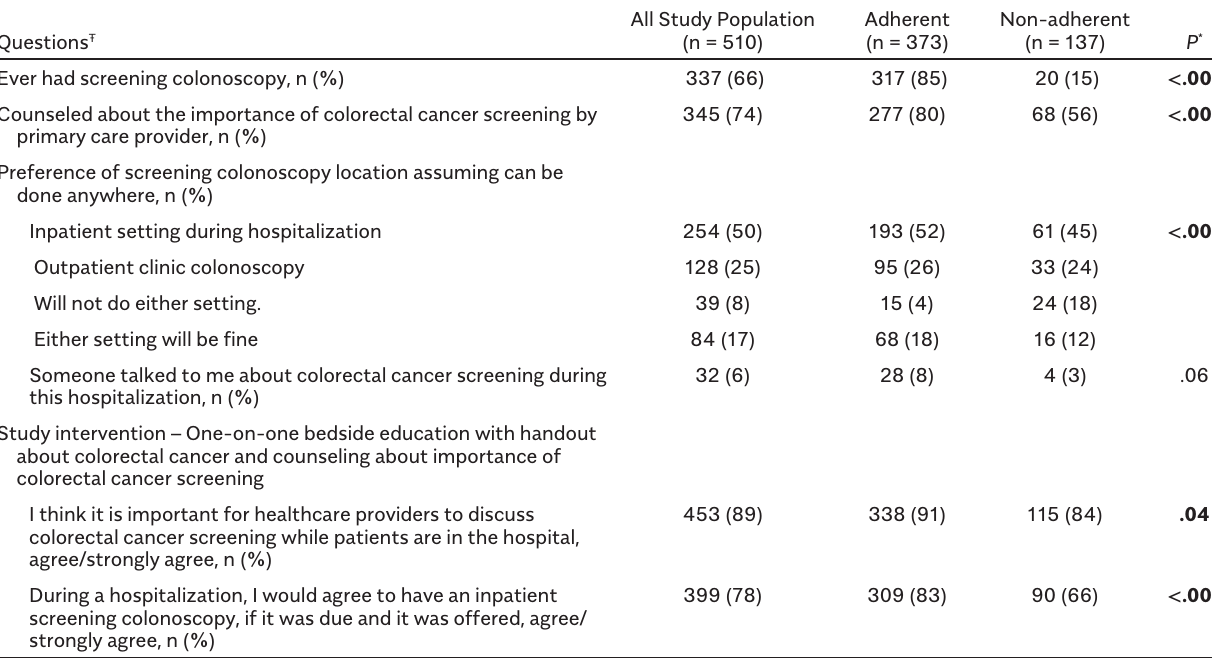
Table 3. Care Received During Hospital Admission and Preferences for